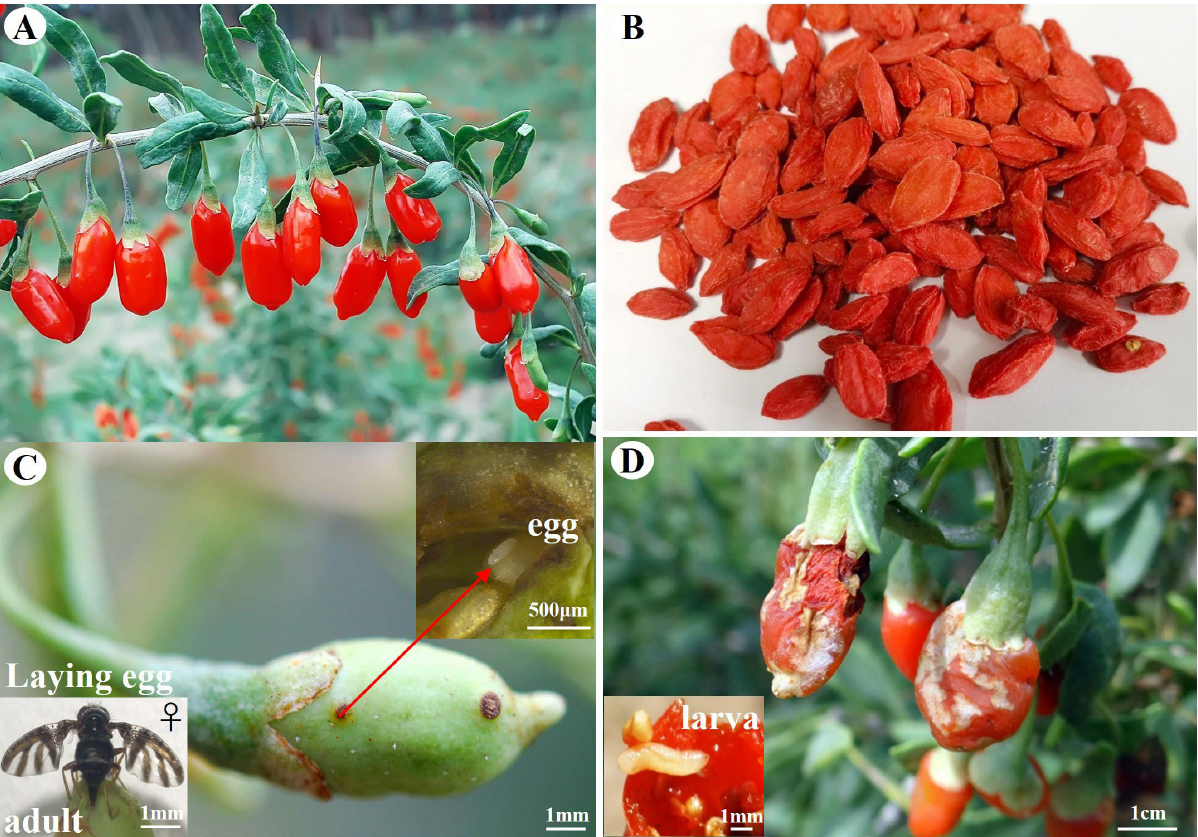
Figure 1. Lycium barbarum L. and the symptoms of its fruits harmed by Neoceratitis asiatica . ( A ) Mature fruits of L. barbarum . ( B ) Dried ripe fruits of L. barbarum L. ( C ) Harmful symptoms of N. asiatica female adult laying eggs on young fruit (5–7 days after falling flower) of L. barbarum L. ( D ) Harmful symptoms of N. asiatica larva on mature fruits (28–31 days after falling flower) of L. barbarum L.